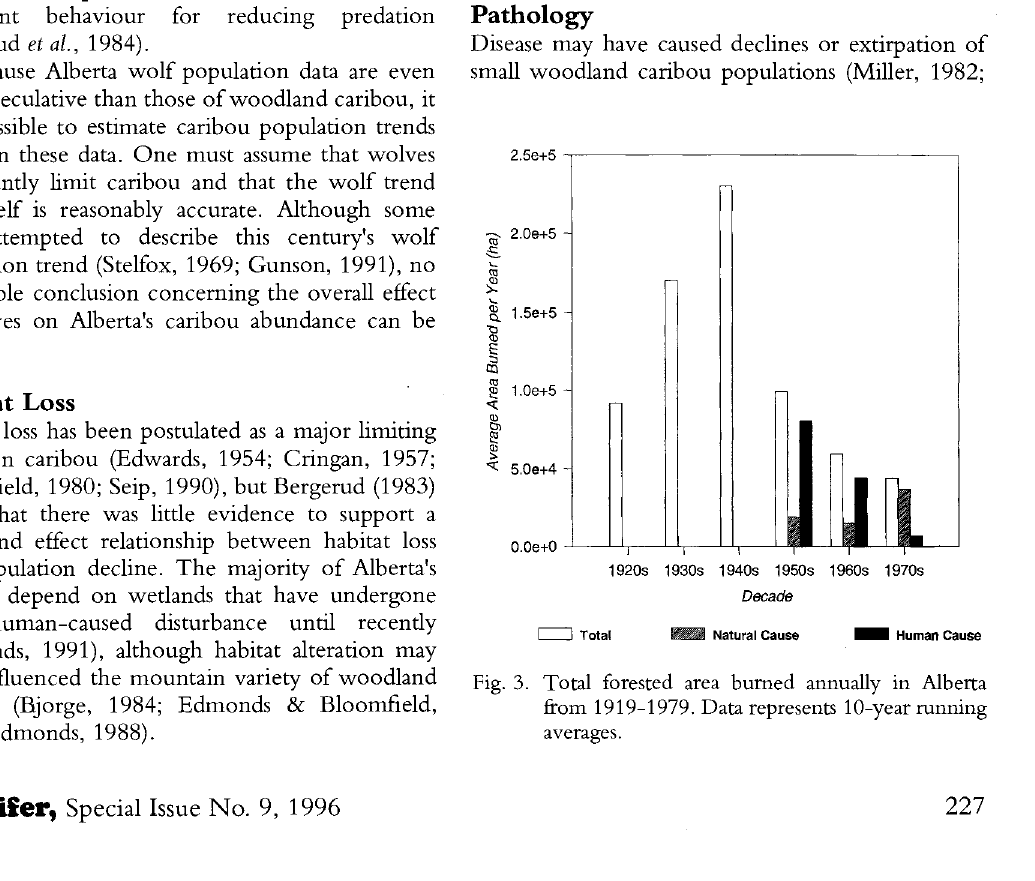
Fig. 3. Total forested area burned annually in Alberta from 1919-1979. Data represents 10-year running